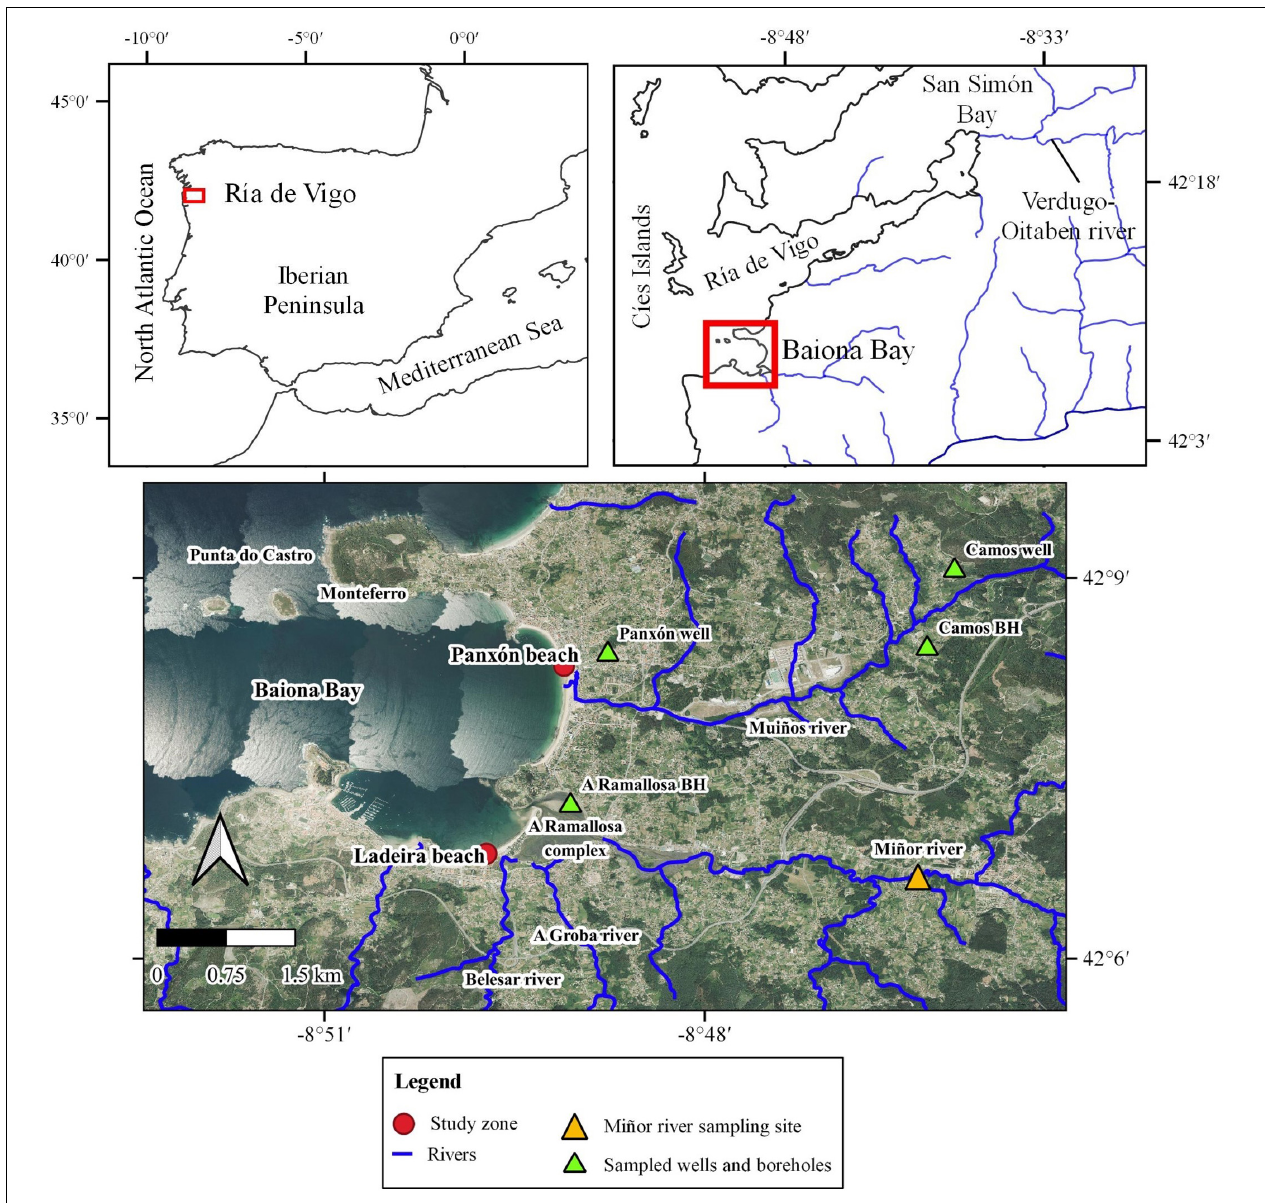
FIGURE 1 | Study area. Sampling sites are identified by red dots. The location of the wells and boreholes used in this study are represented with green triangles, while the location of the Miñor river sampling site is shown with a yellow triangle. These data are obtained from Ibánhez et al. (2019). Orthophoto (taken in 2018) and the mapping of local fluvial courses were obtained from the Instituto Geográfico Nacional (www.ign.es). BH denotes